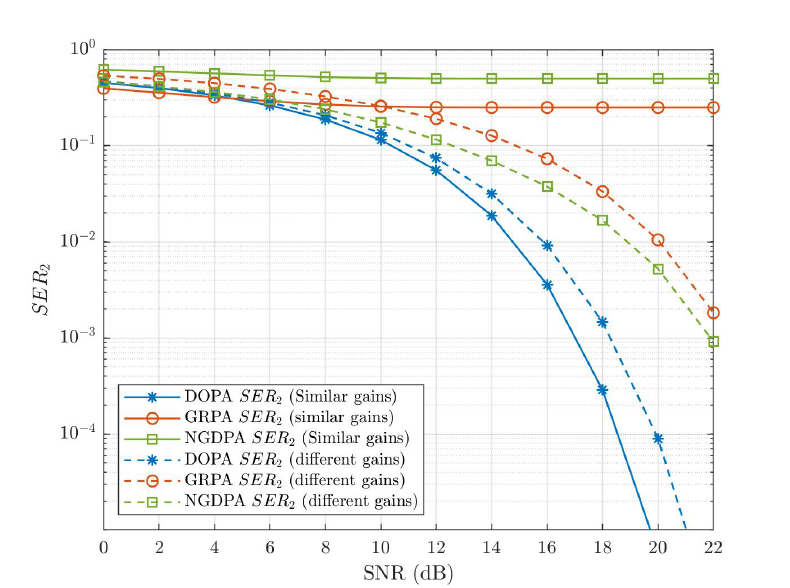
Figure 11. SER 2 using DOPA, GRPA and NGDPA. α = 2 for similar channel gains and α = 1 for different channel gains.